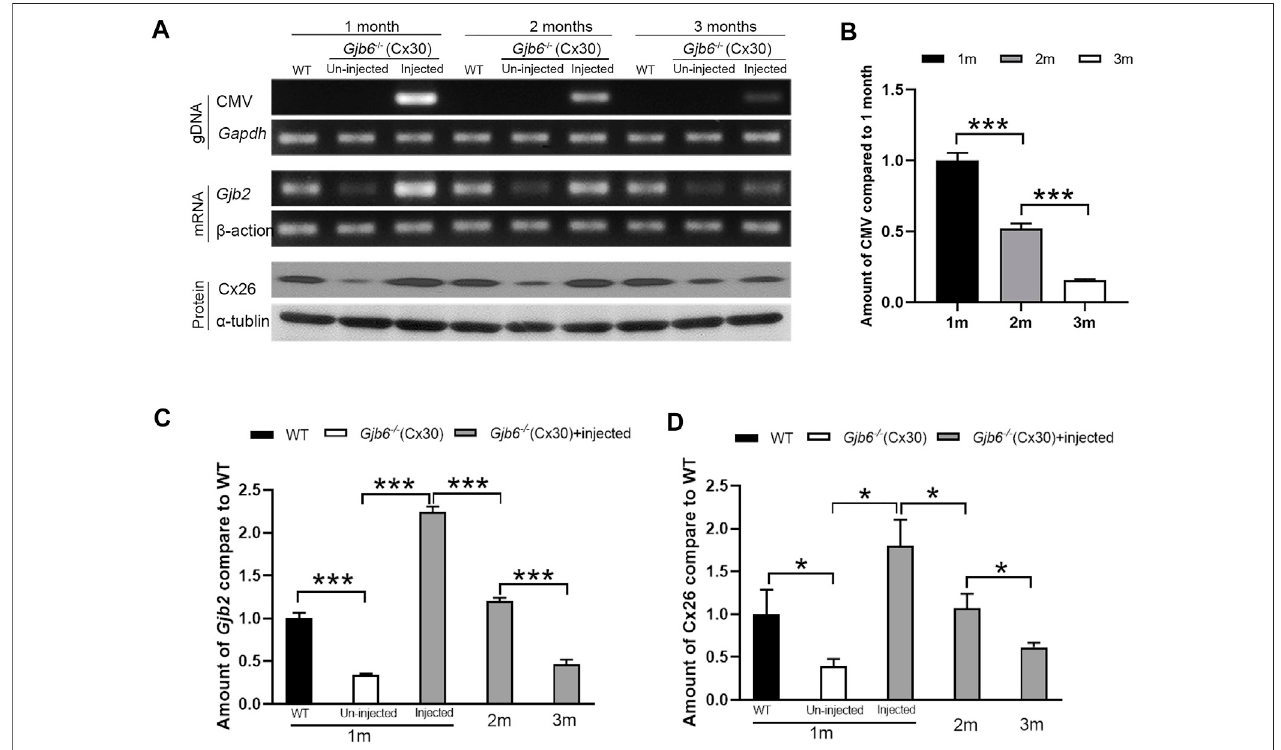
FIGURE 4| Viral titer, Gjb2 expression at the mRNA and protein levels all decreased gradually in Gjb6 − / − mice during the 3 month period after injection with AAV1- CB7- Gjb2 . (A) RepresentativedatashowingthelevelsofAAV1-CB7- Gjb2 genomecopynumbers(toprows), Gjb2 mRNA(middlerows)andCx26proteinlevels(bottom rows) measuredfrom(aslabeledinA)WT,un-injected Gjb6 − / − miceand Gjb6 − / − miceinjected withAAV1-CB7- Gjb2 at1,2and3 months post-injection. Gapdh , β -actin and α -tubulin were used as loading controls for AAV genome, Gjb2 mRNA and Cx26 protein, respectively. (B) Densitometric quanti fi cation of AAV genome (C) Densitometric quanti fi cation of Gjb2 mRNA level from three groups of mice as labelled. (D) Densitometric quanti fi cation of Cx26 protein level as measured by western blots. Error bars in (B – D) represent standard deviation of the mean. n = 3 for each group, * indicates p < 0.05, *** indicates p <